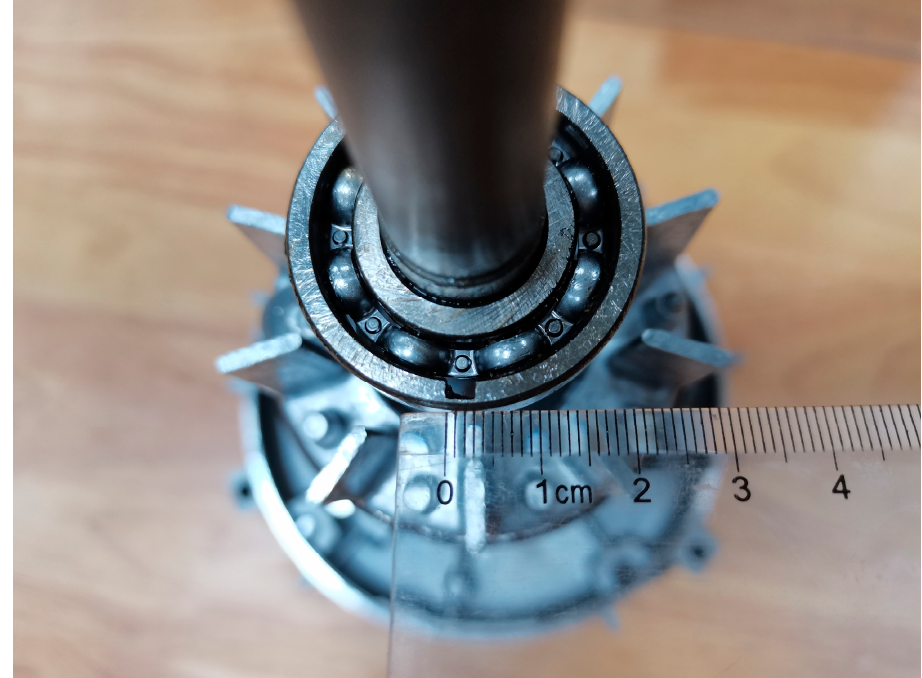
Figure 20. Bearing with outer race spalling at the motor drive